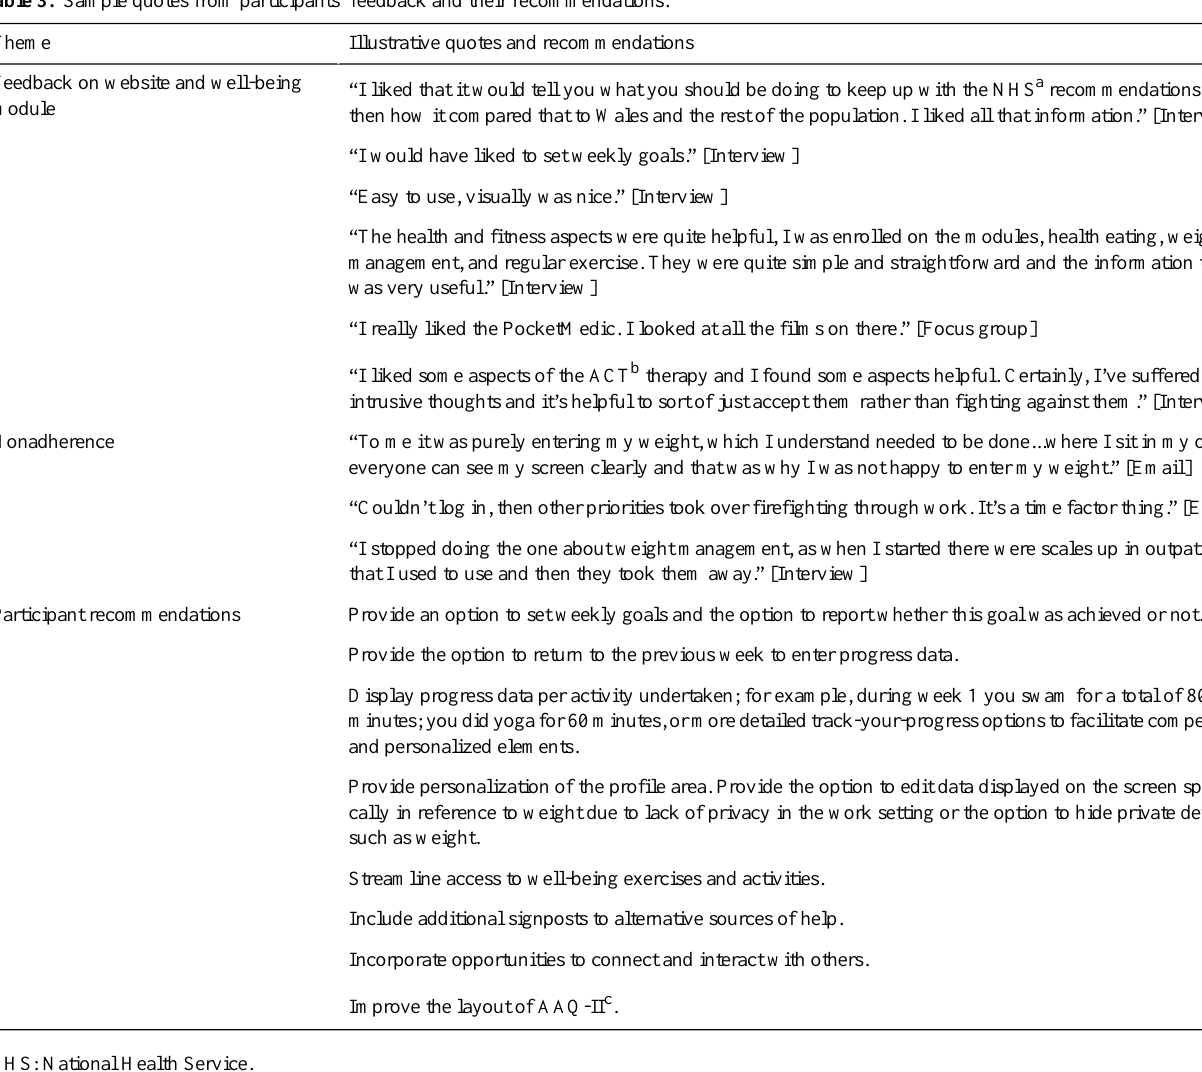
Table 3. Sample quotes from participants’feedback and their